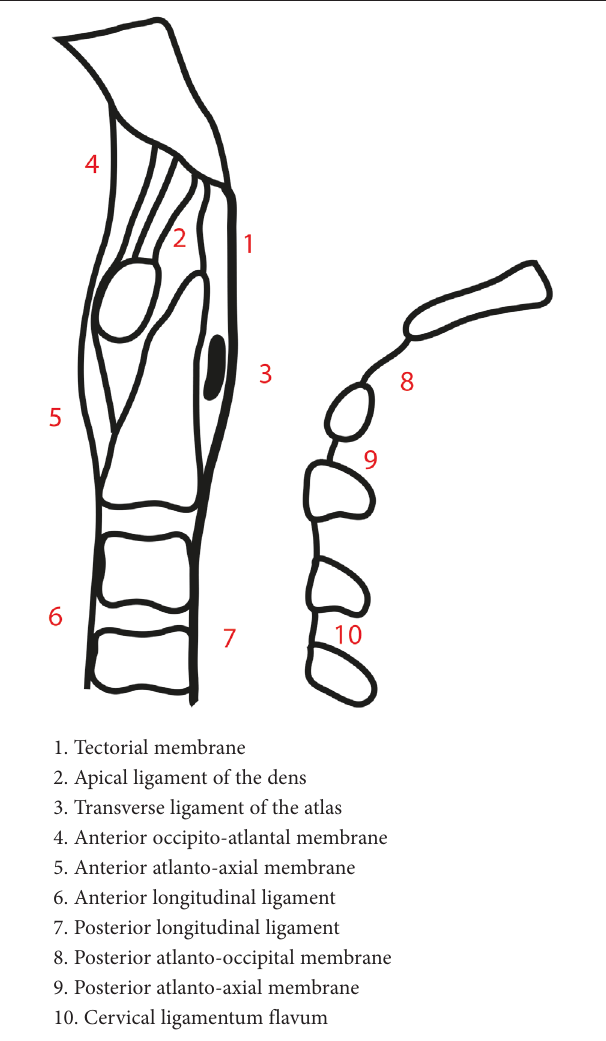
Fig. 1. Sketch showing the key ligaments assessed at the